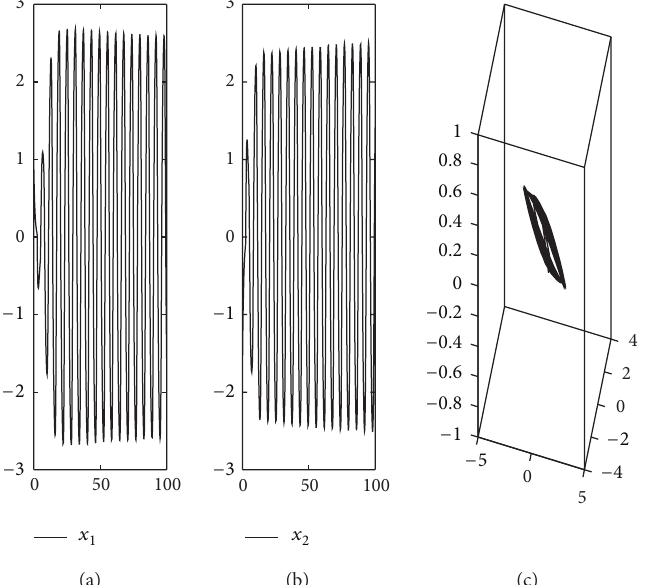
Figure 2: The system (1) undergoes a Hopf bifurcation at (0,0) , and the bifurcating periodic solution is asymptotically stable when 𝜏 = 2.5 ∈ , 𝜏 ) (𝜏 0 1